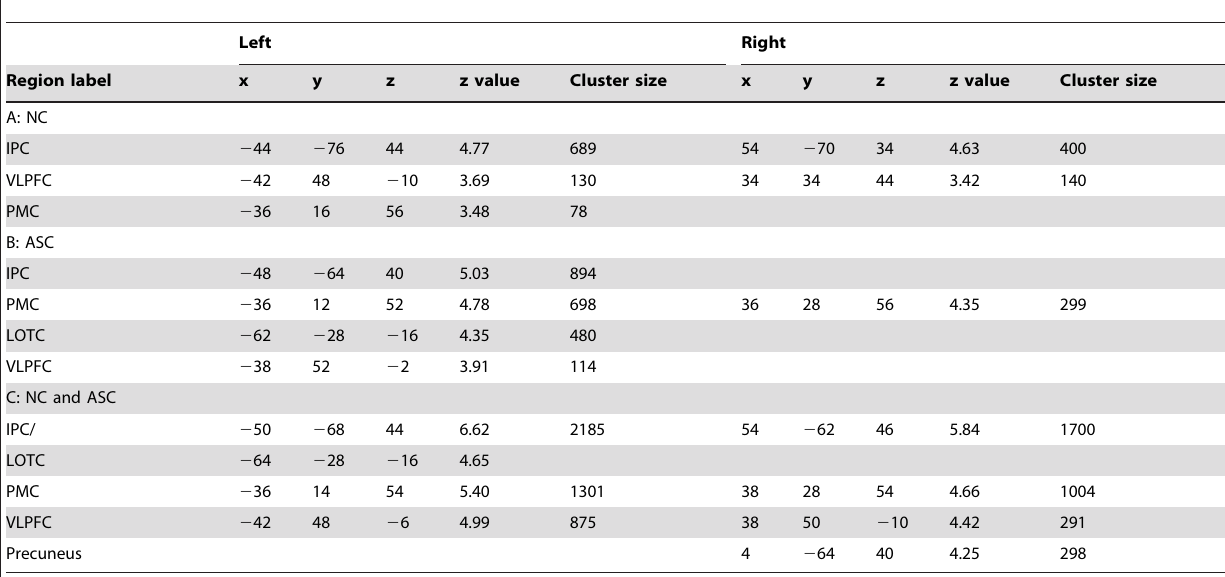
Table 5. Significant activity during the analytic conditions (easy + difficult).